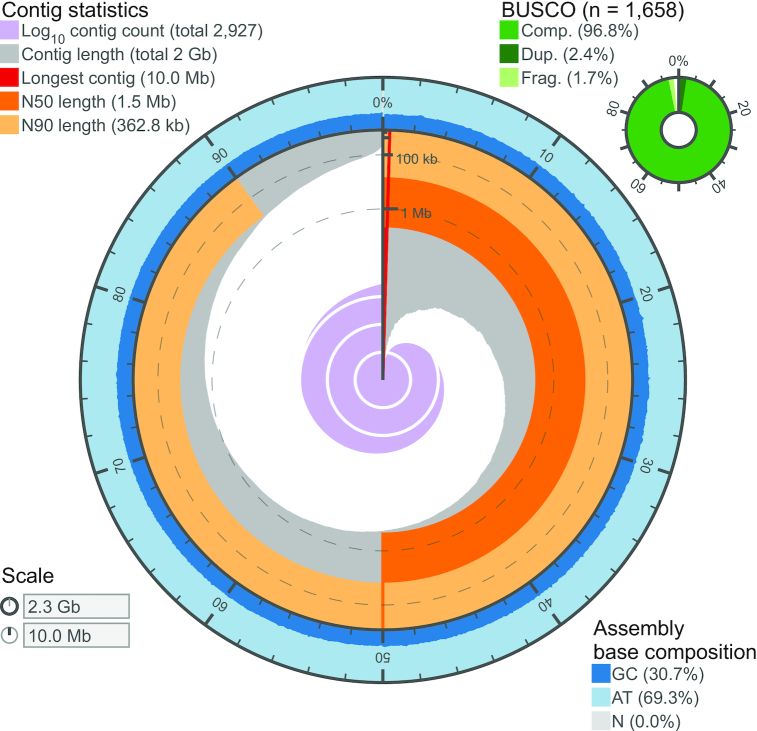
Assembly visualization. The contiguity and completeness of the L. delicatula genome assembly is visualized as a circle, with the full circle representing the full assembly length of ∼2.3 Gb. The longest contig was 10.0 Mb, and the assembly has uniform GC content throughout, with very few contigs <50 kb in length.